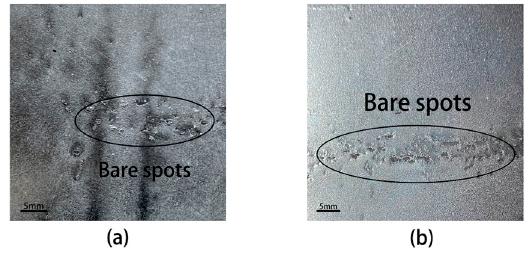
Figure 6. Surfaces of hot-dip galvanized samples annealed in different H 2 content atmospheres. ( a ) 2# (5% H 2 ), ( b ) 3# (20% H 2 ).